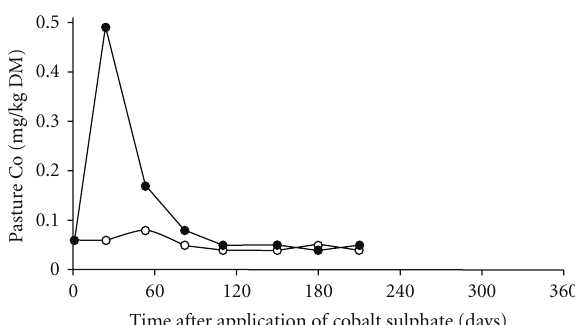
Figure 8: The e ff ect of none ( (cid:2) ) or 350 g cobalt sulphate per hectare (70g Co/ha) ( • ), applied as a solid, on the concentrations of Co in pastures. Adequate intake of Co requires herbage Co > 0.06mg/kg DM for cattle and > 0.10 mg/kg DM for lambs [48].